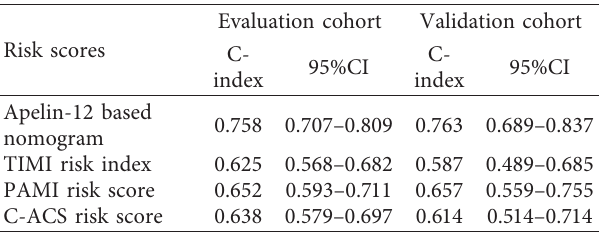
Figure 4: Kaplan-Meier survival curves of the evaluation and validation cohorts categorized into low- and high-risk groups. A significant association between the risk score and MACEs was observed in the evaluation cohort (a) and confirmed in the validation cohort (b). Survival curves between the higher apelin-12 group ( > 0.76 ng/mL) and lower apelin-12 group ( ≤ 0.76ng/mL) in the evaluation cohort (c) and the validation cohort (d). Table 2: Comparisons of C-indexes of the present risk score with other already available risk scores to predict major adverse car- diovascular events in the evaluation and validation data